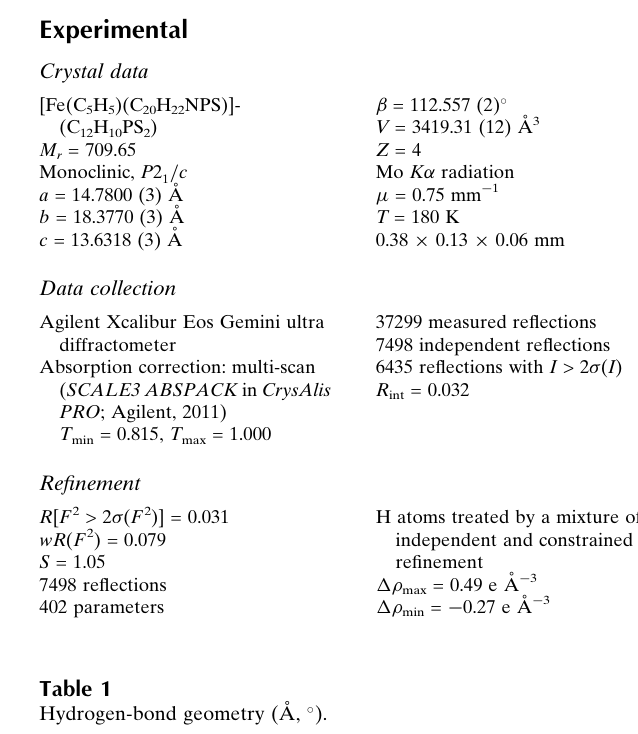
Hydrogen-bond geometry (A˚ , (cid:3)